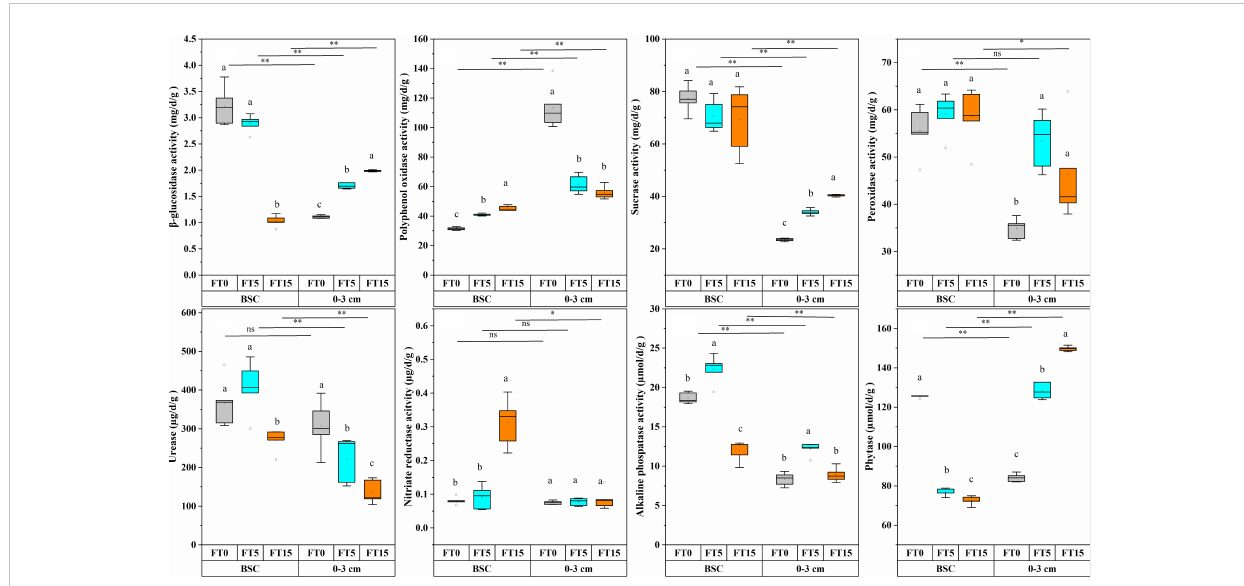
FIGURE 3 Effect of FTC on soil enzyme activity in different soil layers. Results are mean ± SE of fi ve independent replicates. Different lowercase and uppercase letters indicate signi fi cant differences between the FTC treatments (P < 0.05), *(P < 0.05), ** P < 0.01), and ns (P >